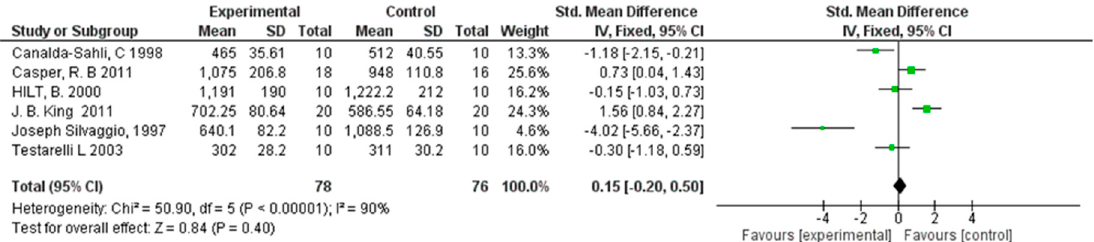
Figure 2. Forest plot of the random effects model of the meta-analysis of the secondary outcome.